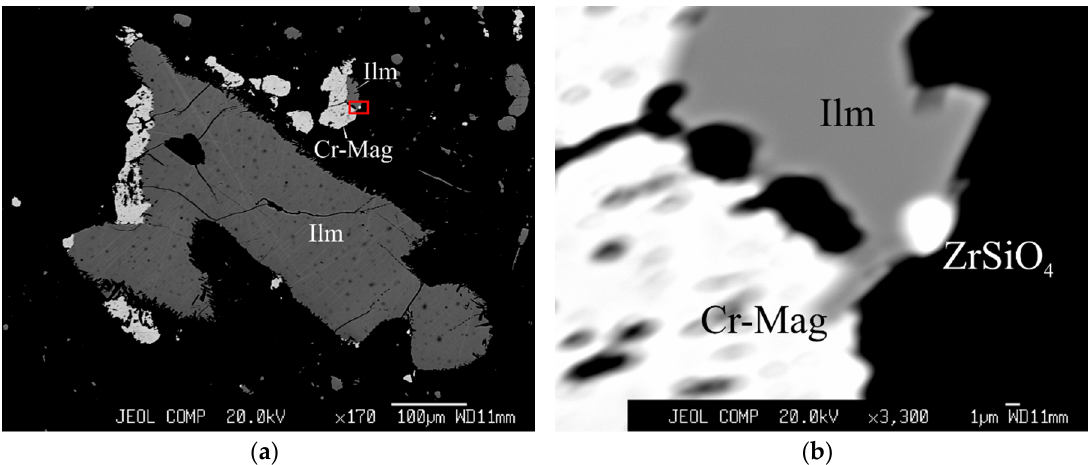
Figure 3. ( a ) Back-scattered electron image of ilmenite, Cr-rich magnetite, and zircon intergrowth (the Moriany intrusion). Sample 10143; ( b ) Enlarged fragment of Figure 3a (red rectangle). Ilm: ilmenite; Cr-Mag: Cr-rich magnetite; ZrSiO 4 : zircon.